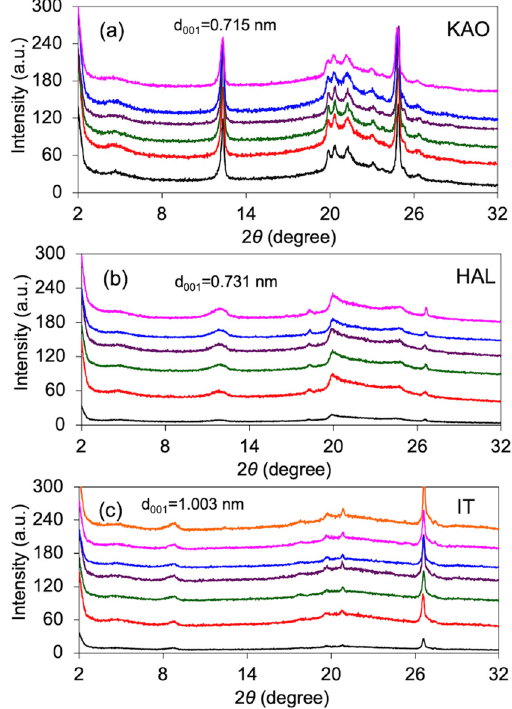
Figure 5. XRD patterns of KAO ( a ), HAL ( b ), and IT ( c ) showing no expansion of any peaks after sorption of AO. From bottom up, the initial AO concentrations were 0, 1, 2, 3, 4, and 5 mM.